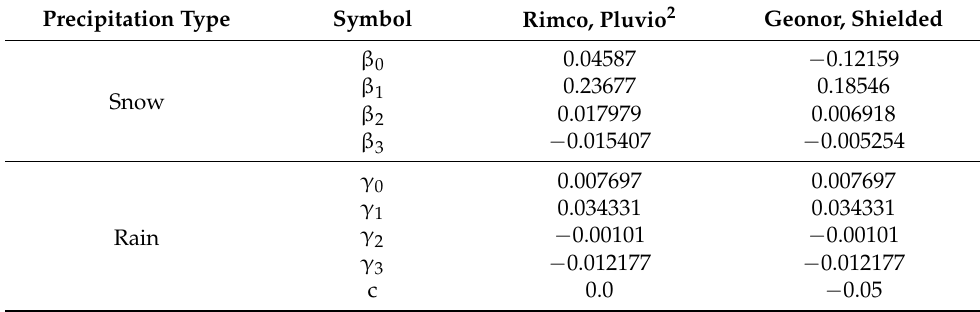
Table A1. Empirical constants for solid and liquid precipitation for three rain gauge types: Geonor, Pluvio 2 , and Rimco [28,30,31]. Empirical constants for the manual Danish Hellmann rain gauge